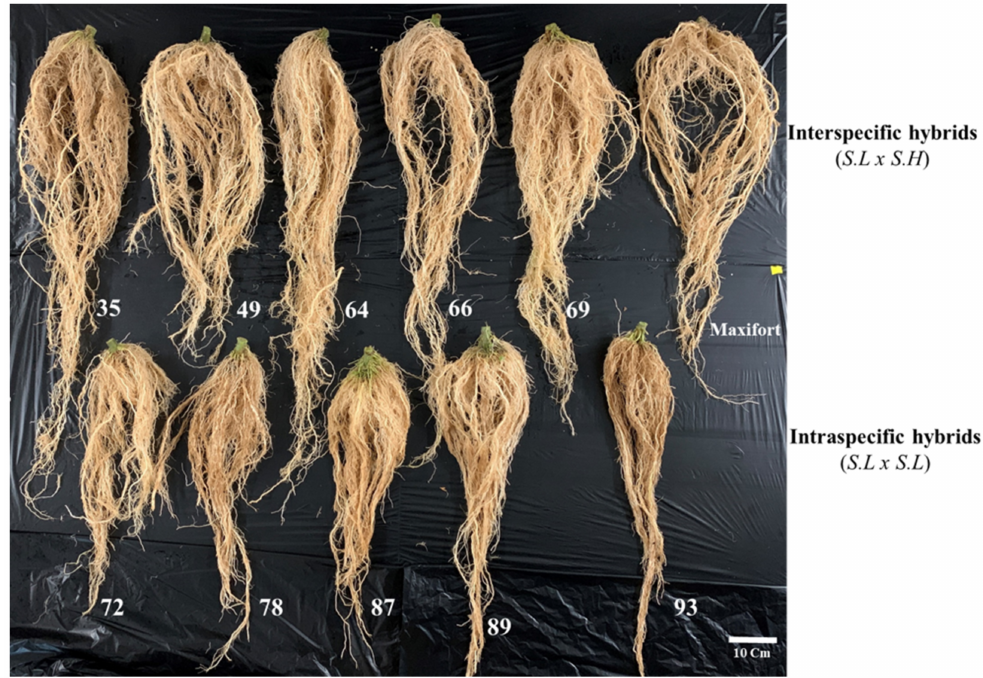
Figure 4. The morphology of tomato interspecific-hybrids ( S. l × S. h ) and intraspecific-hybrids ( S. l × S. l ) hybrid rootstocks at 60 days after transplanting, 35 = (JTS21-3 × SN-08), 49 = (JTS21-3 × SN-20), 64 = (JTS21-3 × SN-33), 66 = (JTS25-5 × SN-33), 69 = (JTS28-4 × SN-33), 72 = (JTS01-3 × JTS33-3), 78 = (JTS35-3 × JTS33-3), 87 = (JTS11-4 × JTS35-4), 89 = (JTS35-3 × JTS35-4), 93 = (JTS25-5 × JTS35-4), Maxifort